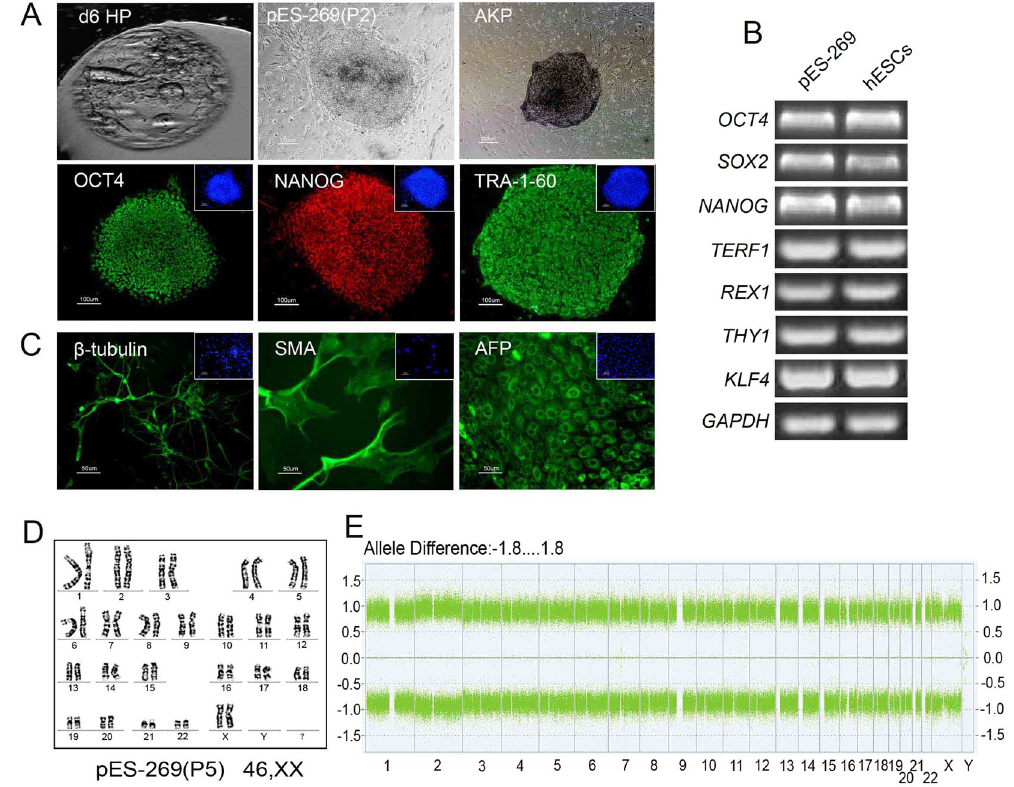
Figure 4. Isolation and characterization of pES-269 cells with commonly used markers. ( A ) pES-269 cells isolation, Alkaline phosphatase (AKP) staining and immunofluorescence staining using anti-OCT4, -NANOG and -TRA-1-60 antibodies; ( B ) RT-PCR assays for the expression of pluripotency-associated markers in pES- 269 cells; ( C ) Immunostaining of differentiated cells from embryoid bodies (EBs) formed by pES-269 cells, using antibodies against β -tubulin (ectoderm), SMA (mesoderm), and AFP (endoderm); ( D ) Karyotype analysis of pES-269 cells; ( E ) Genome-wide SNP analysis of pES-269 cells using an Affymetrix 250 K SNP Array. A homozygous AA allele maps to approximately + 1, and a homozygous BB allele maps to approximately − 1, with the heterozygote mapping to approximately